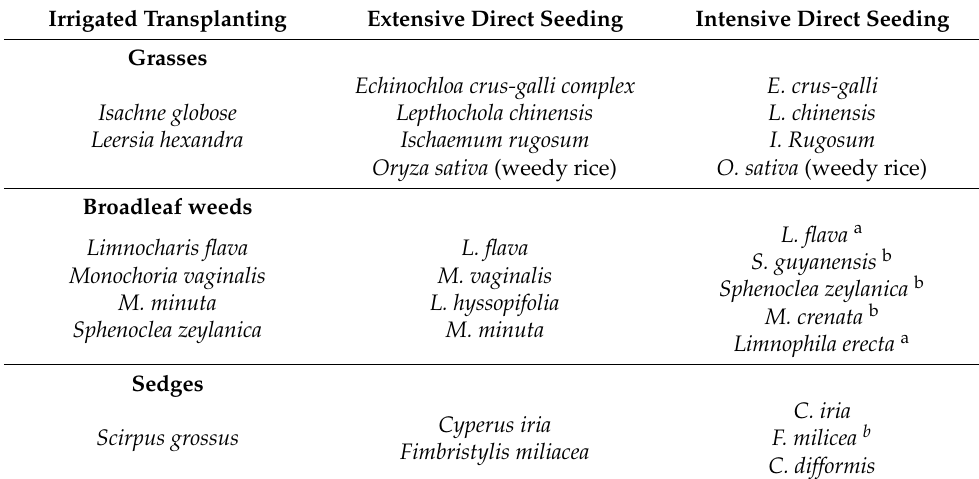
Table 2. Weed shift from transplanting to the direct-seeding